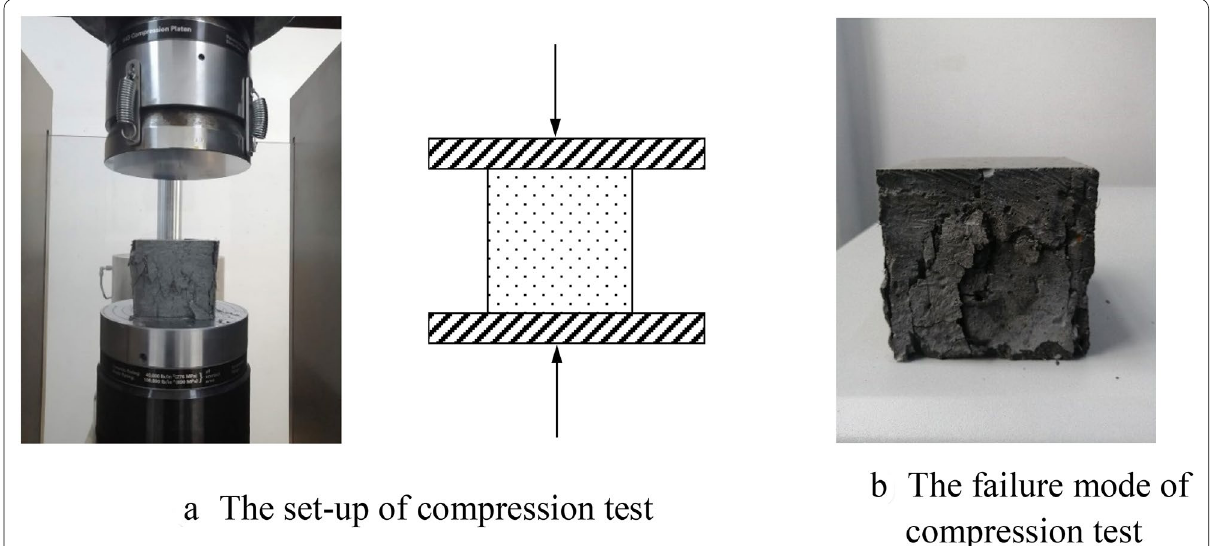
Fig. 2 The set-up and failure mode of compression test: a the set-up of compression test, and b the failure mode of compression test